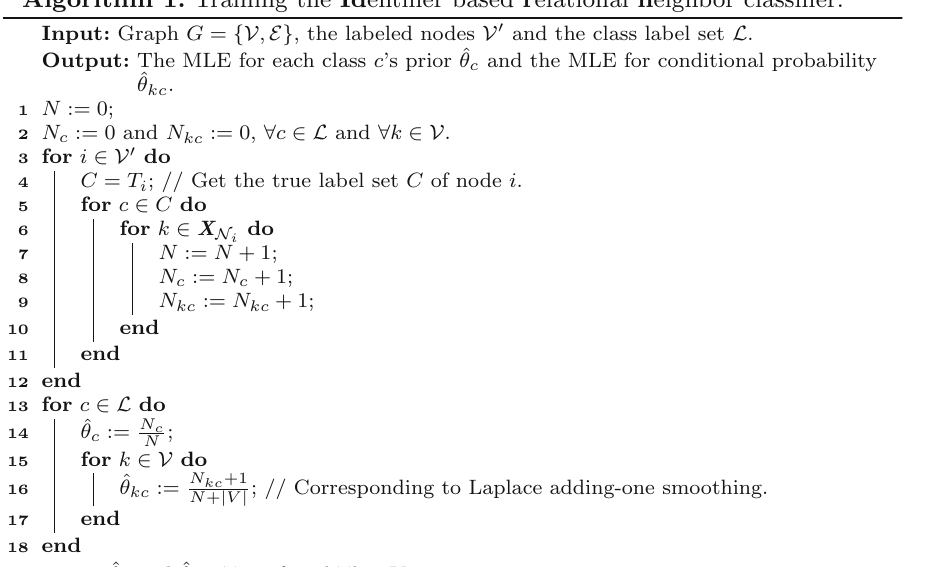
Algorithm 1: Training the Id entifier based r elational n eighbor